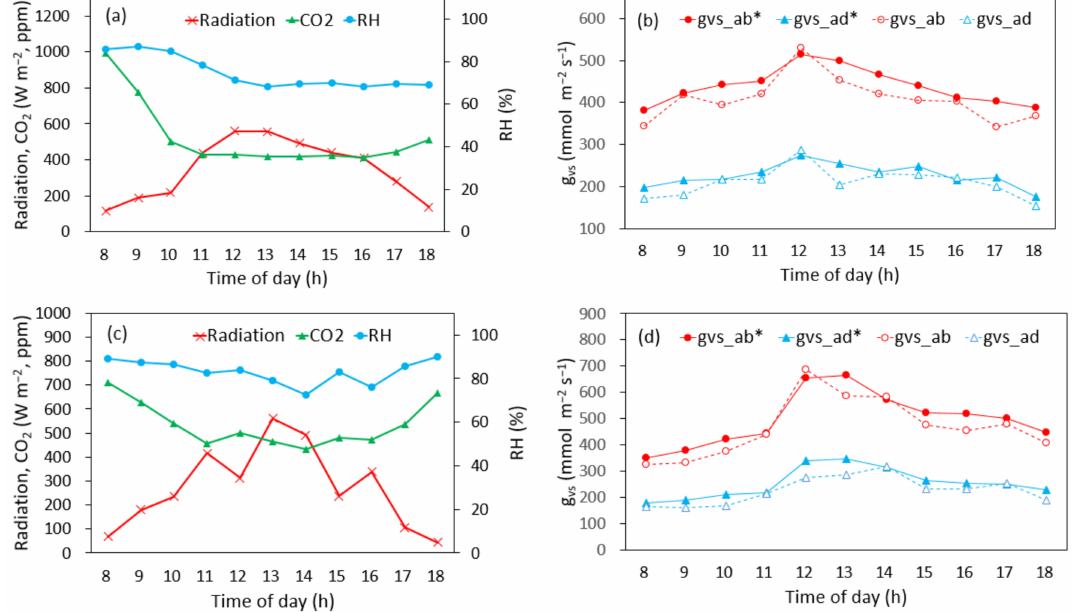
Figure 4. Measurements of stomatal conductance in different climate conditions in the greenhouse for 2 days in LAI3. ( a ) Greenhouse climate measured on 18 September 2021, ( b ) stomatal conductance at that time, ( c ) climate measured on 22 September, and ( d ) conductance at that time, where gvs_ab*, gvs_ad*, gvs_ab, and gvs_ad are the stomatal conductance of the abaxial side in sunlit, adaxial side in sunlit, abaxial side in shade, and adaxial side in shade,